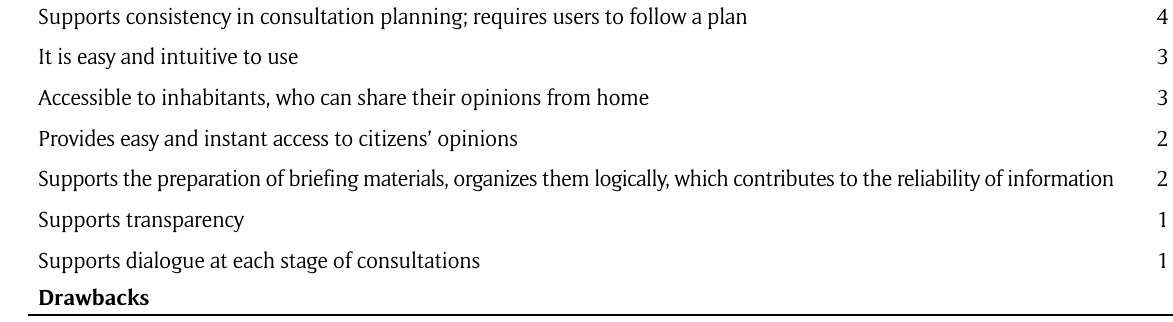
Table 1: Advantages and drawbacks of using inDialogue.